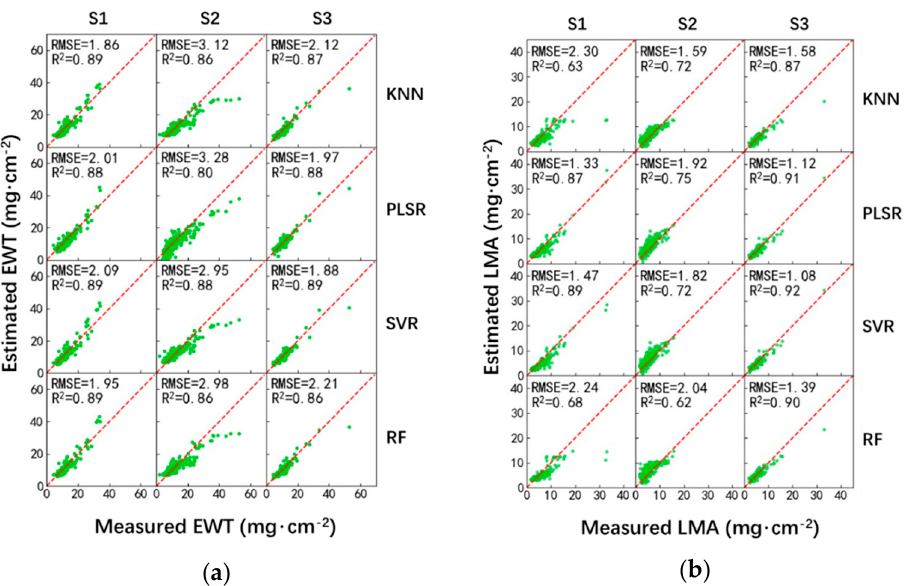
Figure 4. Performance of EWT ( a ) and LMA ( b ) estimation using machine learning (ML)-VI-based method.